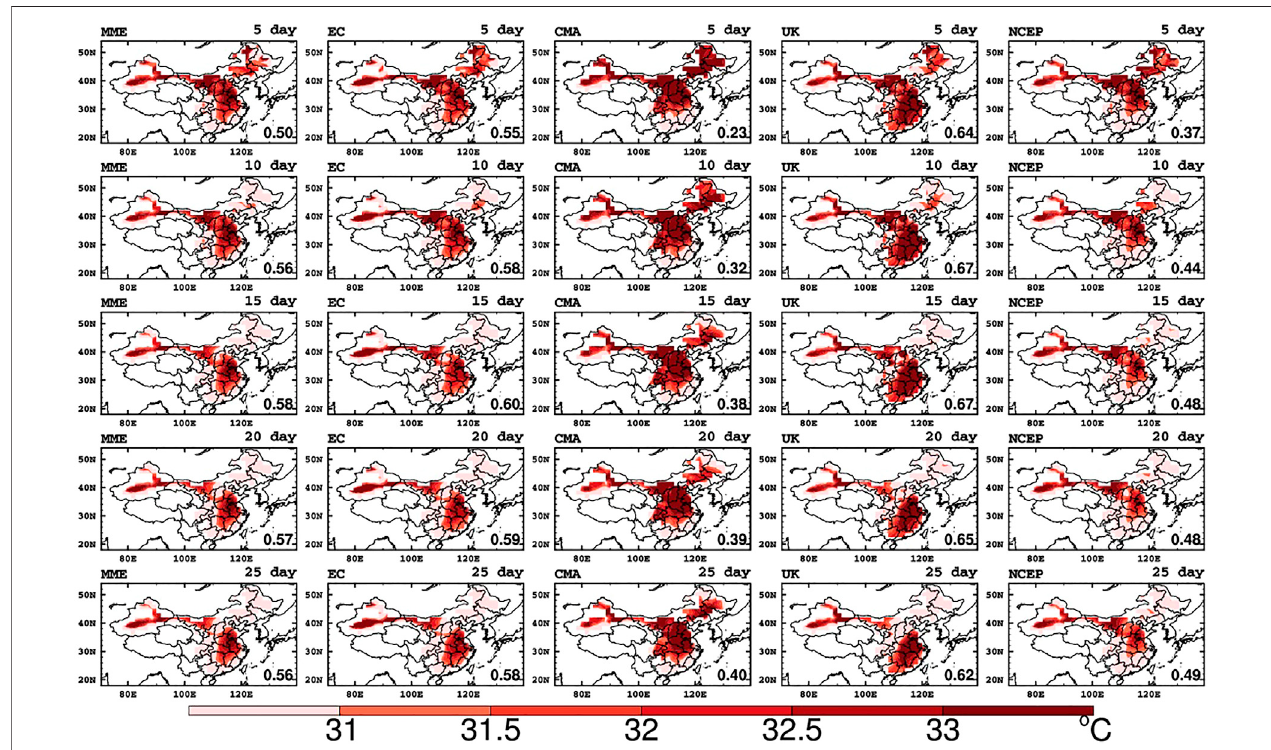
FIGURE3| The thresholds ( ° C) of HWI for MME, EC, CMA, UK, NCEP (columns from left to right) forecasts from the different forecasting valid days (5-, 10-, 15-, 20-, 25-days; rows from top to bottom). The digits in the lower right corner of each panel are the correlation of this pattern with the observational threshold pattern.